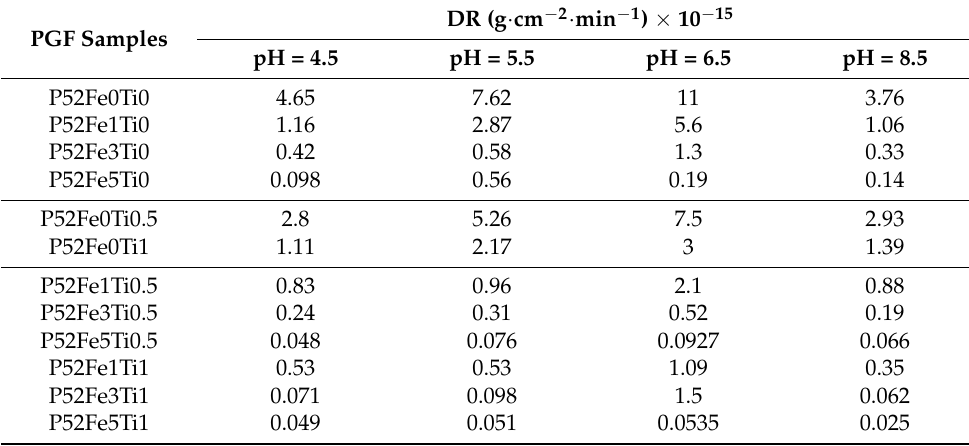
Table 2. The dissolution rate of Phosphate glasses fibers. PGF Samples